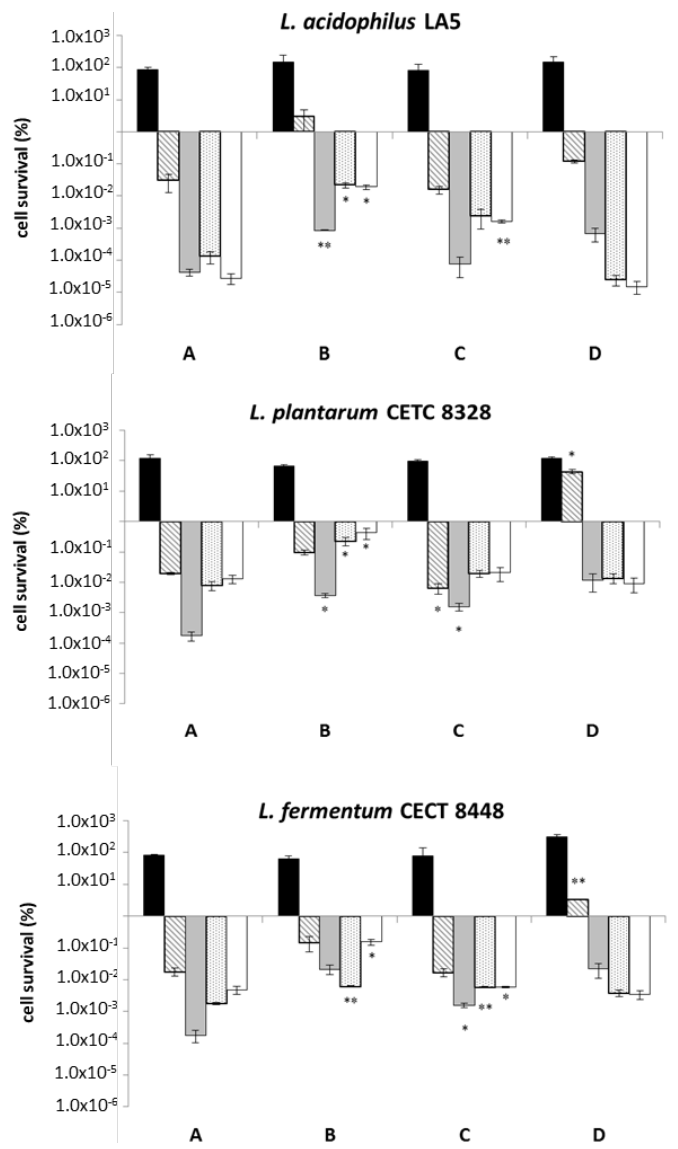
Figure 2. Percentage of cell survival after in vitro oro-gastrointestinal tract simulation, including oral , gastric (pH 2.0 and pH 3.0 ), and intestinal (small and large intestine ) stresses conveying microorganisms in saline solution (negative control) and three different food matrices (not-enriched pasta; β-glucans enriched pasta; barley flour). Values represent mean ± standard deviation of three different experiments. Statistical analysis was carried out by Student’s t -test (* p < 0.05 and ** p < 0.005) and